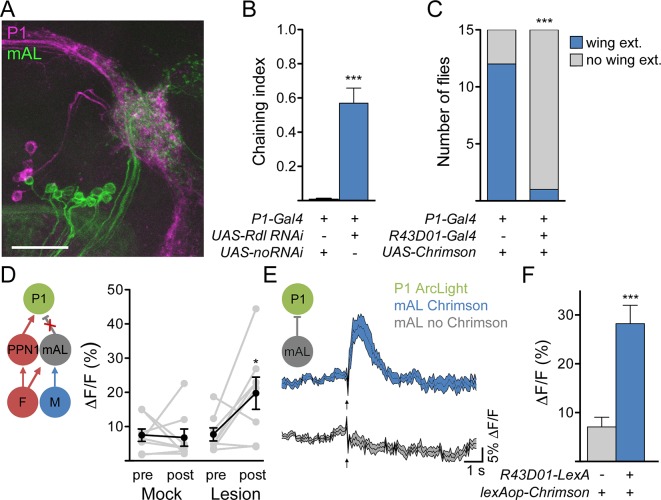
mAL neurons functionally and behaviorally inhibit P1 neurons.(A) Overlap between mAL (green) and P1 (magenta) in the superior lateral protocerebrum (collapsed 97-μm stack). Scale bar is 25 μm. (B) Knockdown of GABAA receptor Rdl in P1 neurons induces male-male chaining; n = 10/condition. (C) Chrimson-mediated activation of P1 neurons causes wing extension (wing ext.) in solitary males, which is suppressed by co-activation of neurons expressing R43D01-Gal4. (D). Lesioning mAL axons increases GCaMP response in P1 upon P2X2-mediated stimulation of F+M cells. (E) Chrimson-mediated activation of mAL neurons causes P1 hyperpolarization, as detected by increased ArcLight fluorescence. Arrow indicates laser. F. Maximum ΔF/Fin P1; n = 10–11/condition. Data are Mean ± SEM. Mann-Whitney test (B, F), Fisher’s exact test (C), or paired t-test (D). *p<0.05, **p<0.01, ***p<0.001.